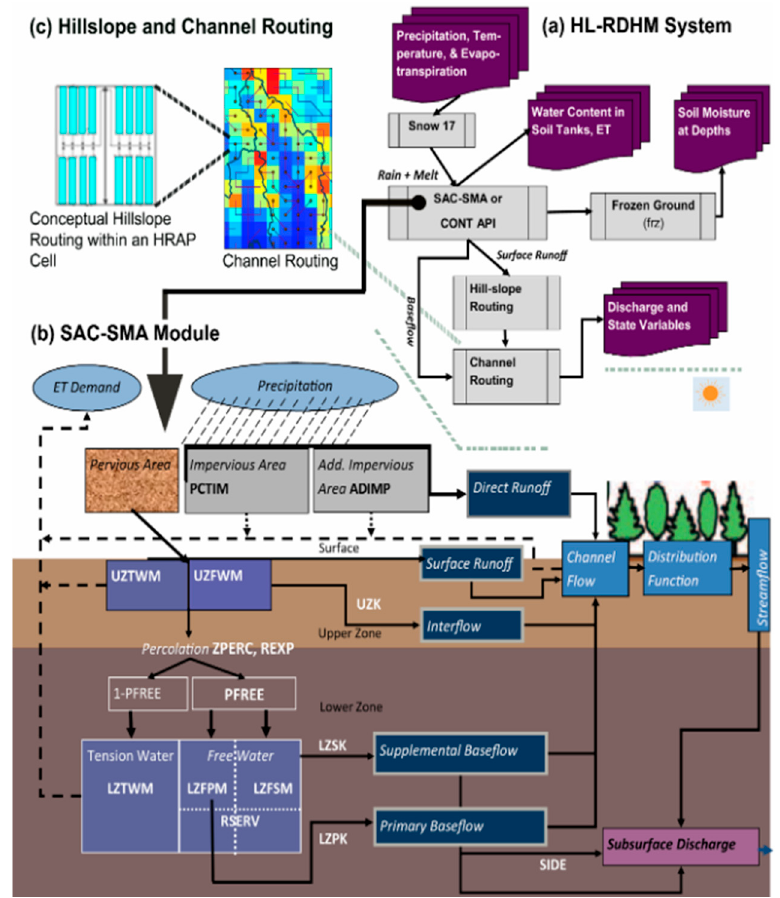
Figure 3. Components of the RDHM.